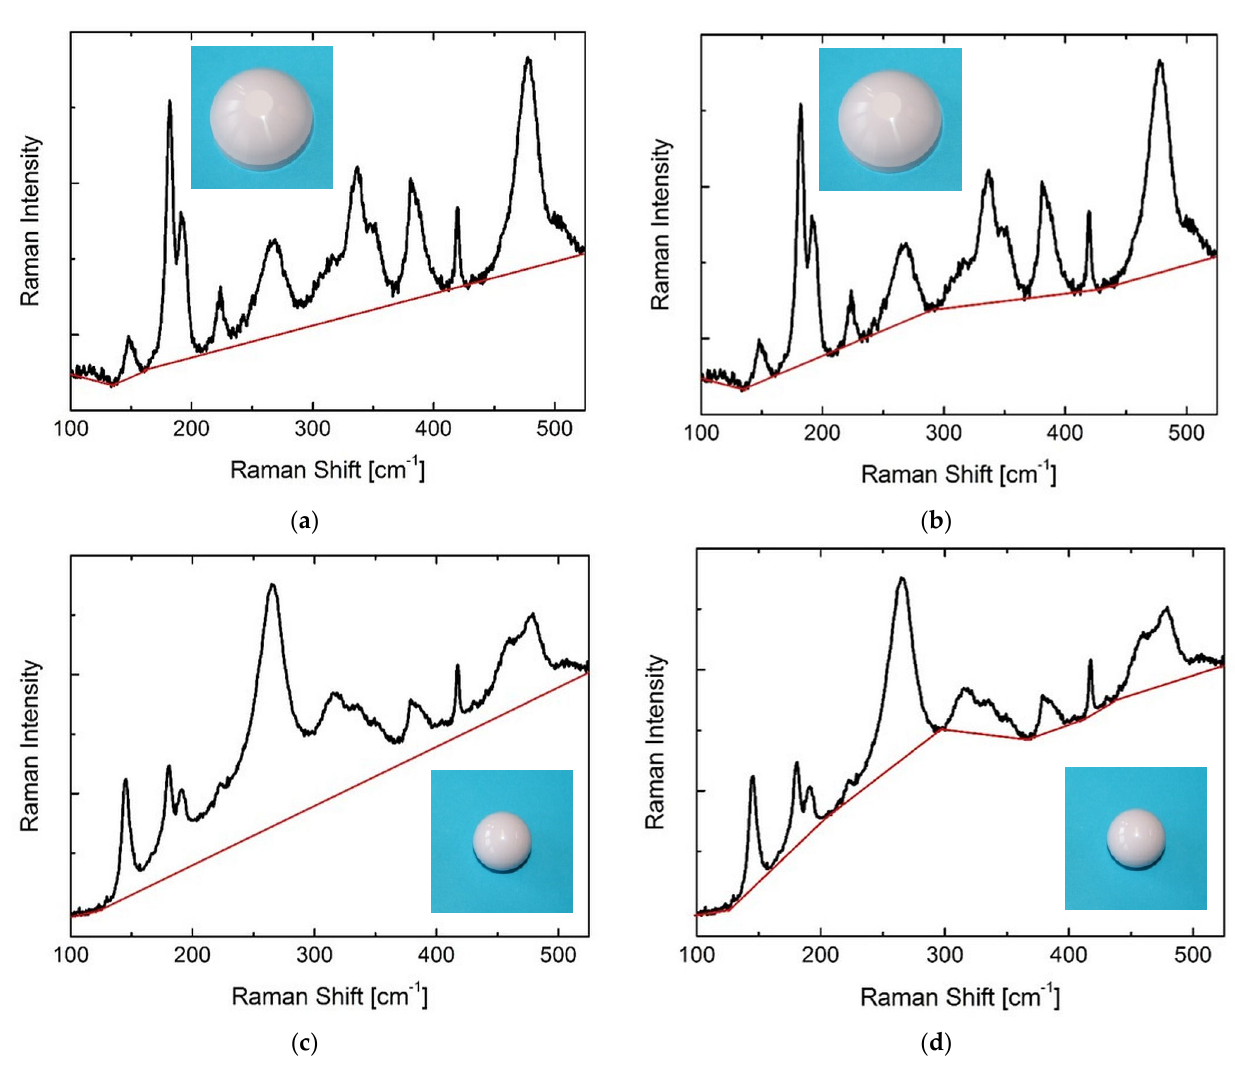
Figure 7. Different baseline choices on Raman spectra of Delta with ( a , b ) high and ( c , d ) low monoclinic contents. The spectrum shown in ( a , b ) was collected on the rear of an insert (rough surface), whereas the spectrum shown in ( c , d ) was collected on the apex of a head (polished surface).